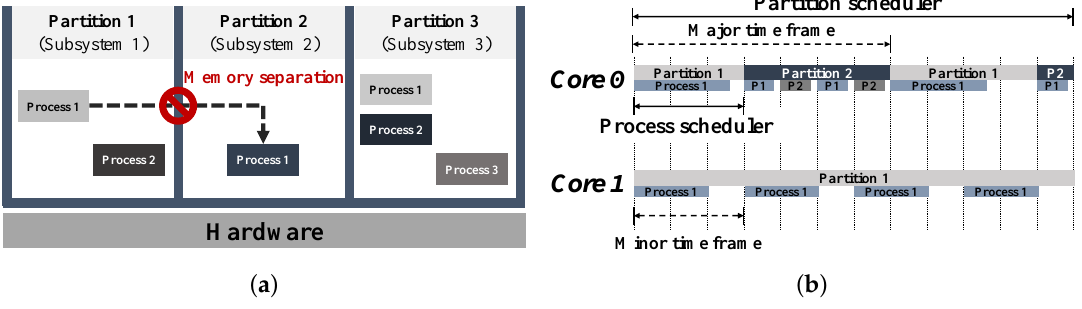
Figure 2. Temporal and spatial separation of the partitioning system. ( a ) Spatial separation. ( b ) Temporal